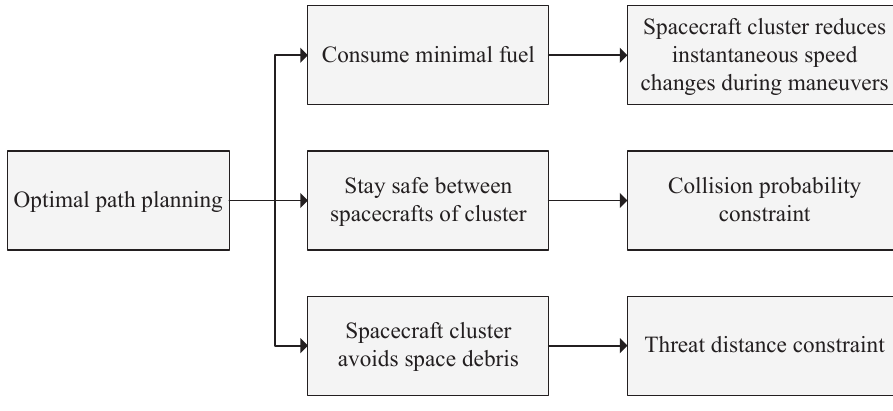
Figure 2. Diagram of fitness function for path